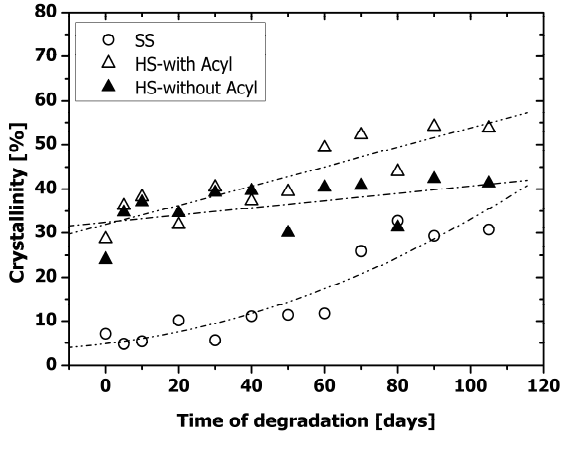
Figure 7. Percentage hard (cryst. HS) and soft segment crystallinity (cryst. SS) upon degradation of PAU1000. ( ○ ) Soft segment (SS) crystallinity (calculated according to Equation 4); ( ∆ ) hard segment crystallinity with the contribution of the acyl carbonyl peak (HS-with Acyl) (calculated according to Equation 3); ( ▲ ) hard segment crystallinity without contribution of the acyl carbonyl peak (HS-without Acyl) (calculated according to Equation